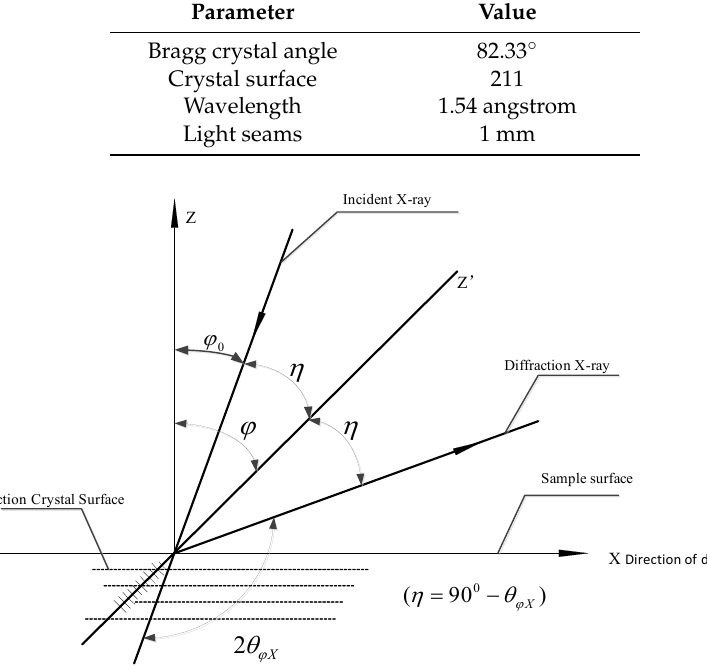
Figure 4. Schematic diagram of residual stress measurement.